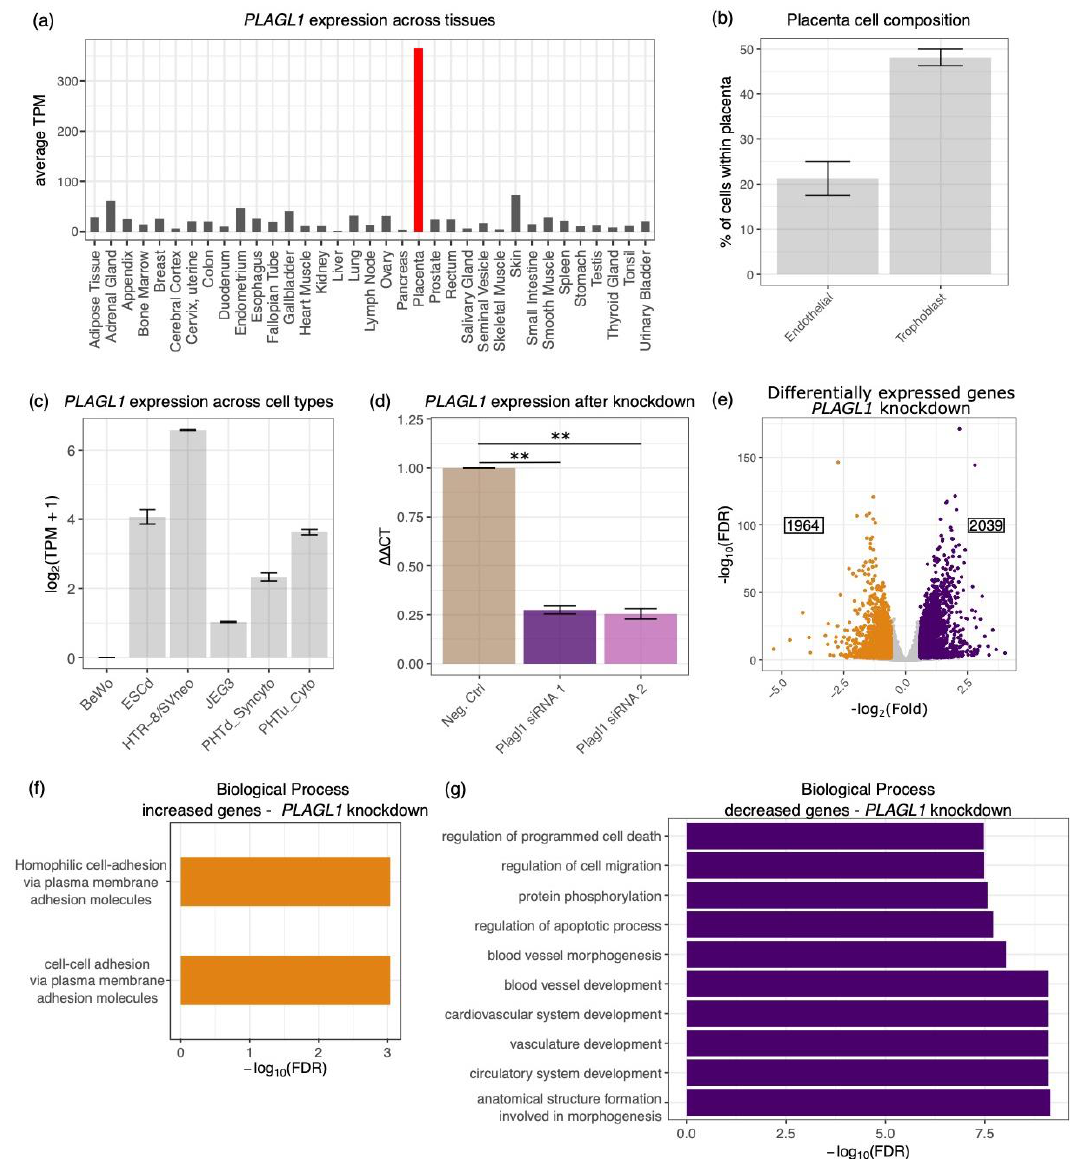
Figure 5. PLAGL1 regulates genes involved in blood vessel development. ( a ) Bar graph of PLAGL1 expression in human tissues, generated using TissueEnrich. Expression reported using transcripts per million (TPM). ( b ) Percentage of trophoblast and endothelial cells in human placental samples. Data is from the Human Protein Atlas. ( c ) Bar graph of PLAGL1 expression in multiple human cell lines. ( d ) PLAGL1 expression is significantly reduced by two siRNAs ( p -value ≤ 0.01 (**)) compared to a negative control. Values are normalized to the negative control siRNA. ( e ) 4003 genes are differentially expressed after PLAGL1 knockdown in HTR-8/SVneo cells. Genes which increase (1964) in expression are indicated as orange dots on the volcano plot and those that decrease (2039) are purple. ( f ) Cell-adhesion terms are associated with genes that are upregulated when PLAGL1 is knocked down. ( g ) Vasculature development terms are associated with genes that are downregulated when PLAGL1 is knocked down.